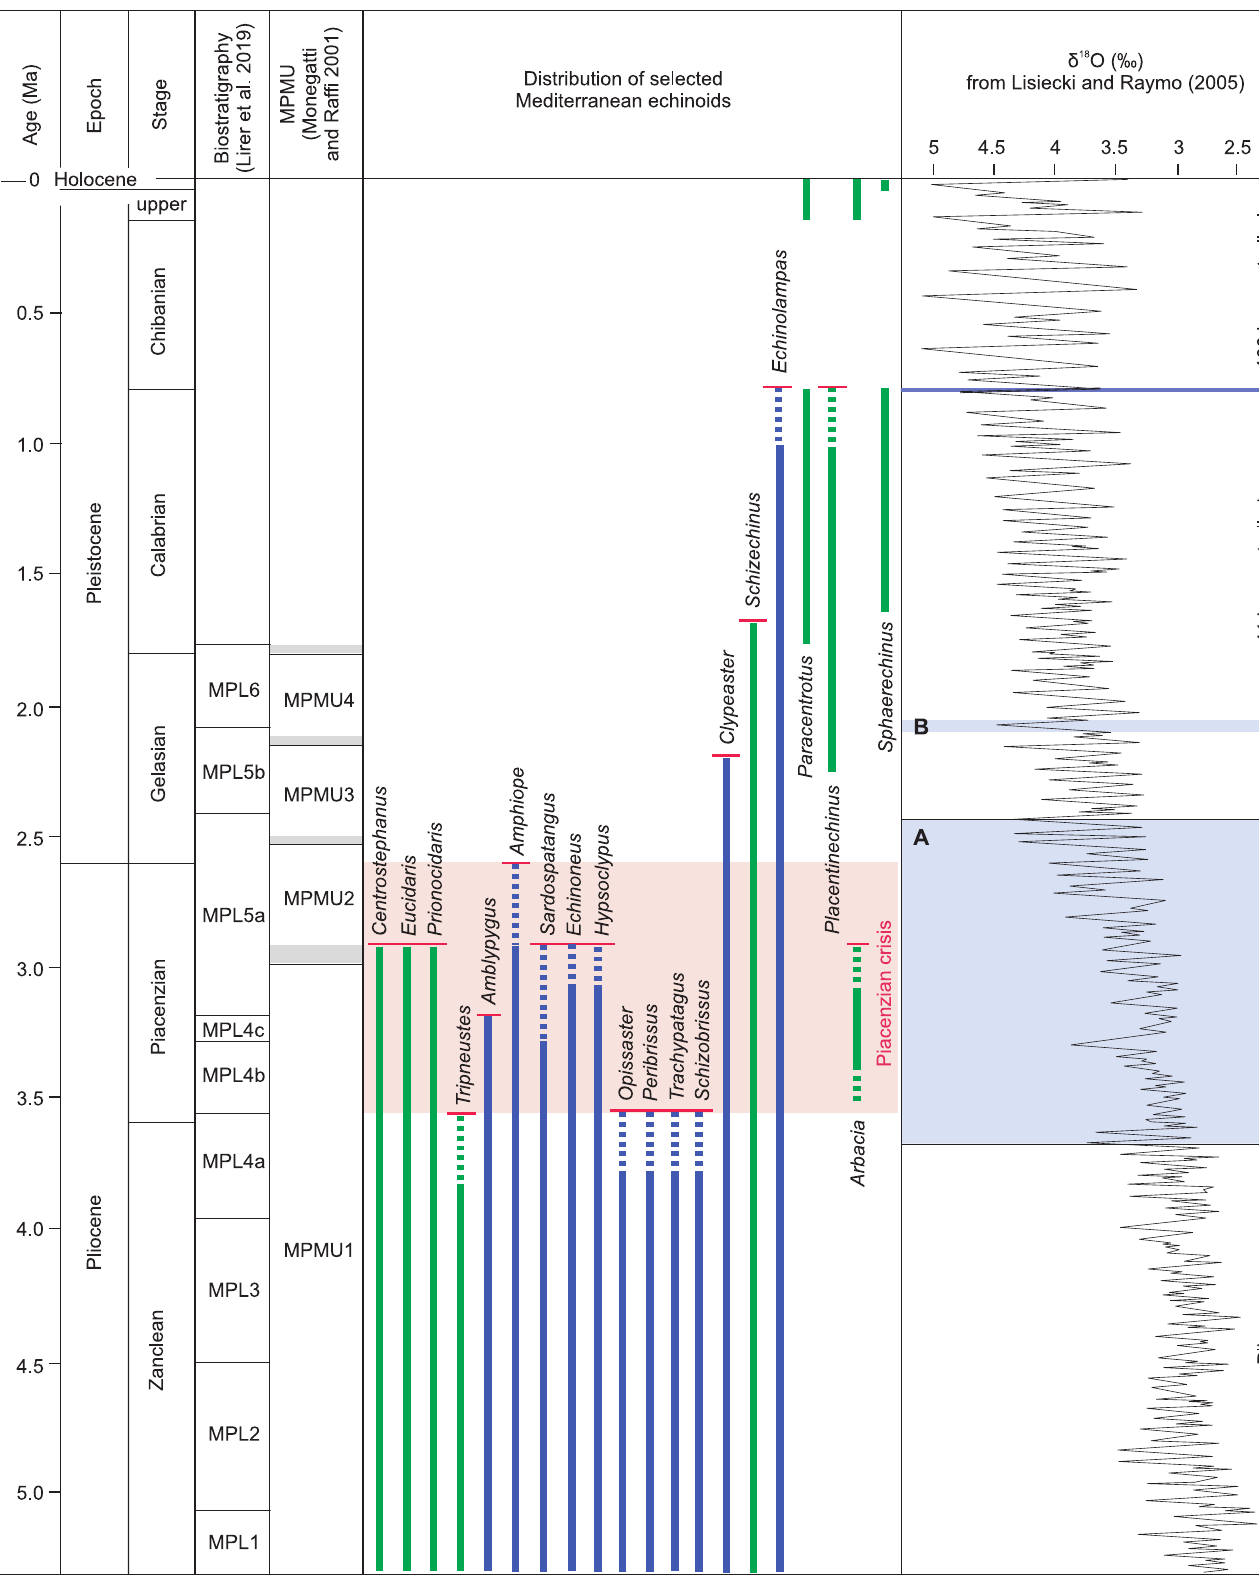
Fig. 6. Mediterranean biostratigraphy of some regular (green) and irregular (blue) echinoid genera showing appearances and disappearances during the Pliocene–Holocene interval. Shaded parts of the δ 18 O curve indicate the beginning and the gradual intensification of the Northern Hemisphere glaciation (A) according to Mudelsee and Raymo (2005), and the remarkable climate deterioration within the Gelasian at around 2.1 Ma (B). Chronostratigraphy is from Cohen et al.